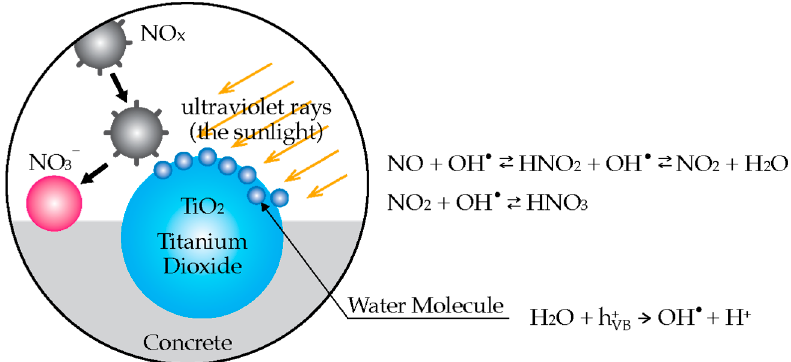
Figure 7. Mechanism of photocatalytic oxidation of NOx at steady state.